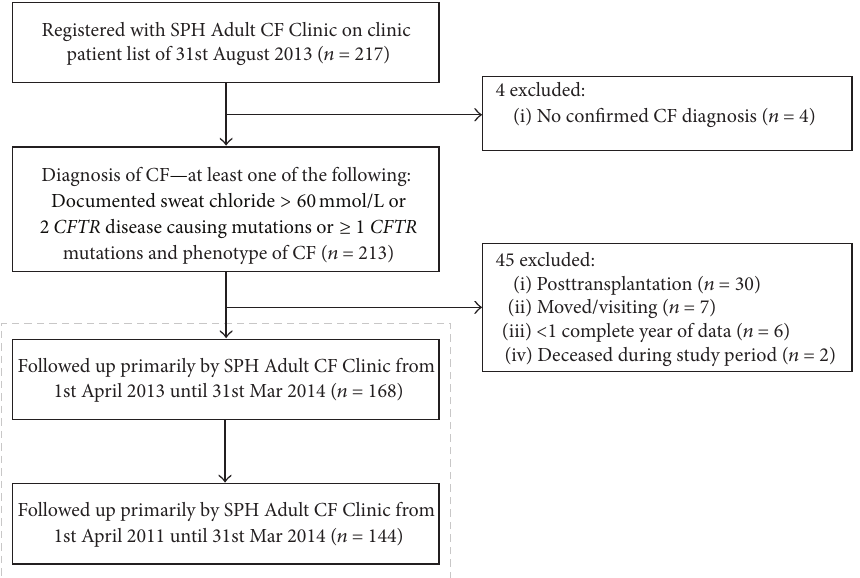
Figure 2: Study inclusion and exclusion